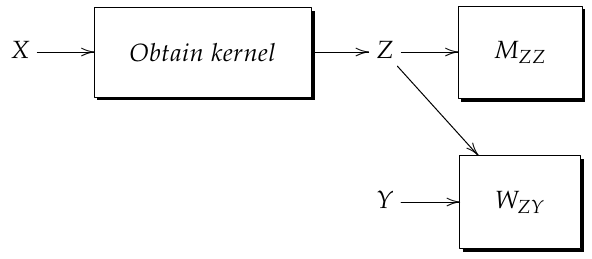
Figure 3. kernel model learning phase.